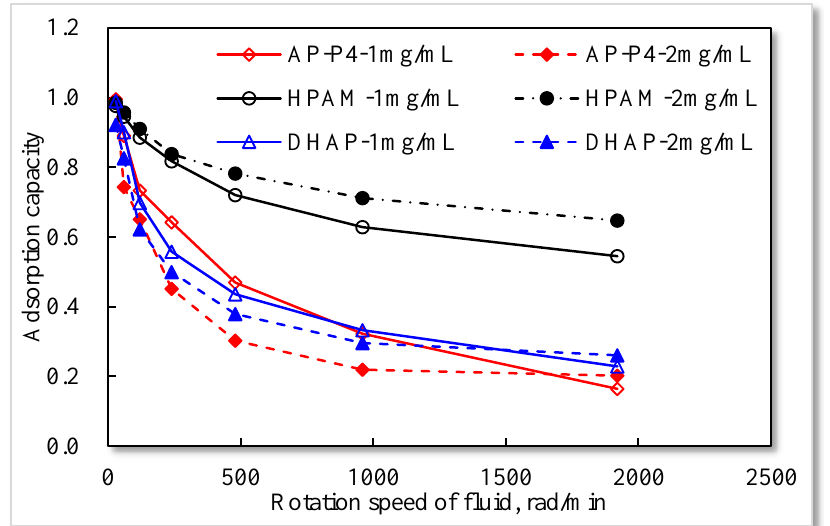
Figure 14. Ratio analysis of dynamic to static adsorption capacity under different stirring rates.